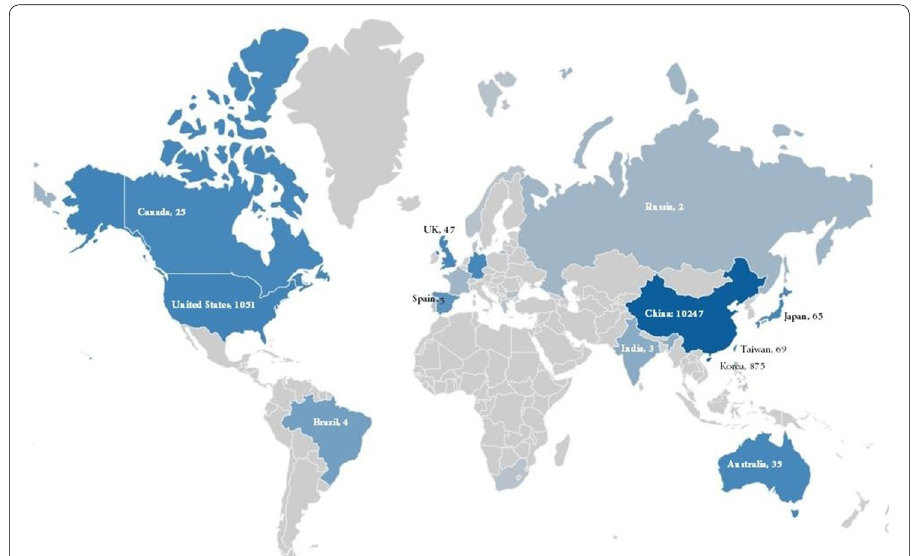
Fig. 6 Map of patent applications filed in various